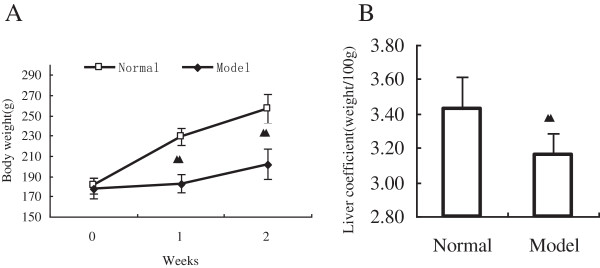
Effect of acute stress on body weight and liver coefficient in rats. A, Results of rat’s weight of submitted after 2 weeks of acute stress. B, Results of the liver coefficient of rats submitted after 2 weeks of acute stress. Data are expressed as mean ± SEM (n = 8). ▲▲P<0.01 versus the normal group.